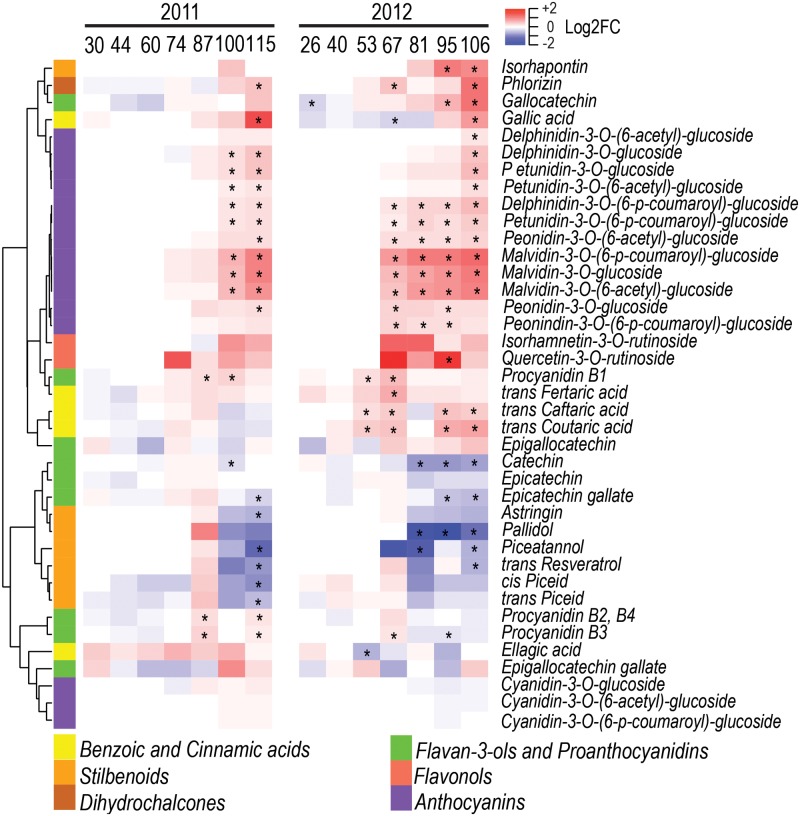
Impact of water deficit on phenolics during berry development in 2011 (left) and 2012 (right). Heatmaps represent log2FC (WD/CT) at each developmental stage. Blue and red color shades indicate lower and higher metabolite concentration in WD than CT, respectively. Asterisks indicate significant differences (P < 0.05) between treatments. Metabolites were hierarchically clustered based on their response to water deficit. The colored side bar on the left indicates the class of metabolites.